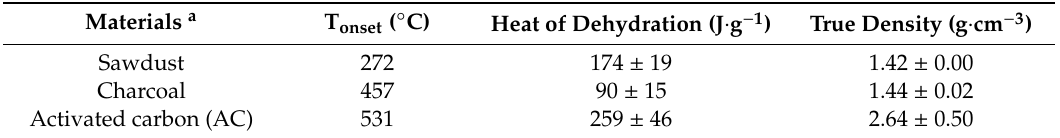
Table 2. Onset degradation temperature (T onset ) obtained by thermogravimetry (C0-TGA), heat of dehydration determined by di ff erential scanning calorimetry (Co-DSC) and true density determined by gas pycnometry for sawdust, charcoal and